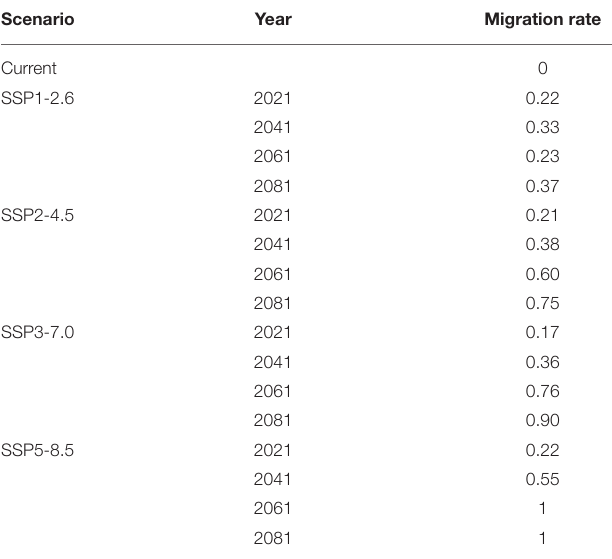
TABLE 2 | Migration rate of the geometric center of Akebia quinata ’s distribution regions in East Asia. Scenario Year Migration rate Current 0